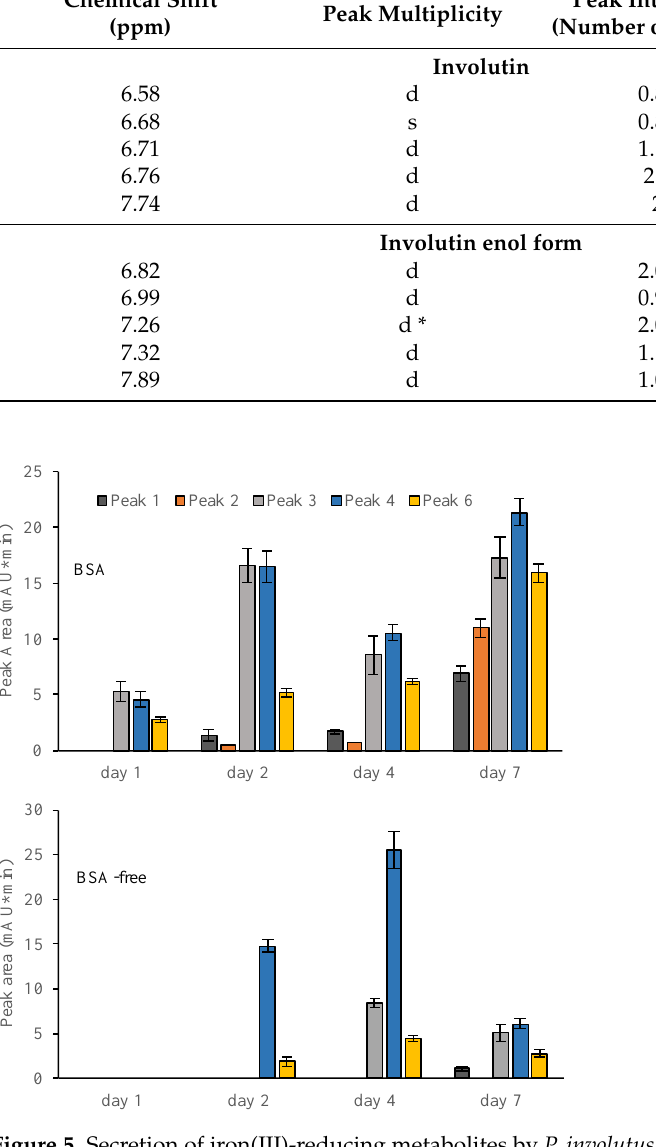
Figure 5. Secretion of iron(III)-reducing metabolites by P. involutus incubated for 1, 2, 4 and 7 days on medium containing BSA (top panel) or BSA-free medium (bottom panel). The peak area of five iron(III)-reducing metabolites are shown. These metabolites were separated using HPLC ( λ = 254 nm). These metabolites were further characterized by mass spectrometry (Figure 4). Bars indicate ± standard deviations ( n = 3). In all samples, equal volumes of culture filtrates were extracted.